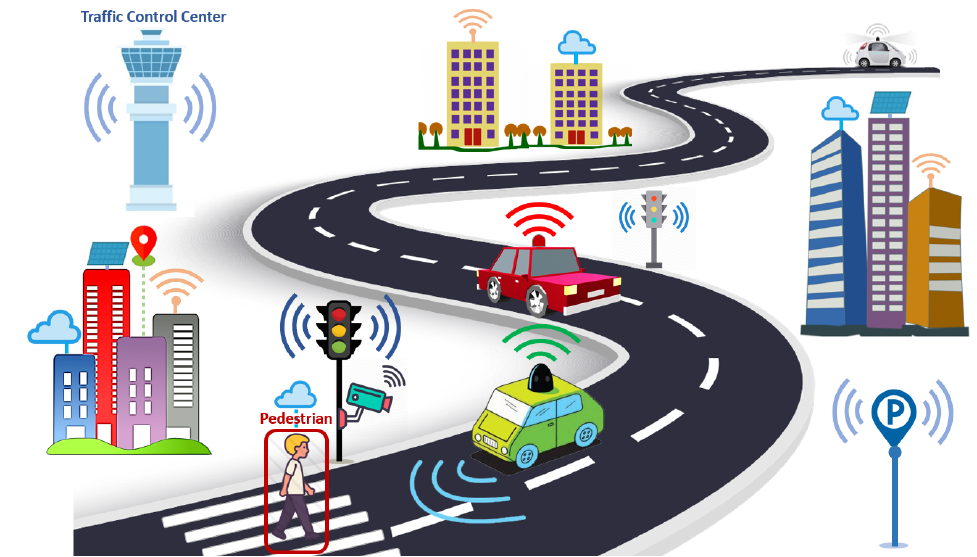
Figure 1. A sample smart city